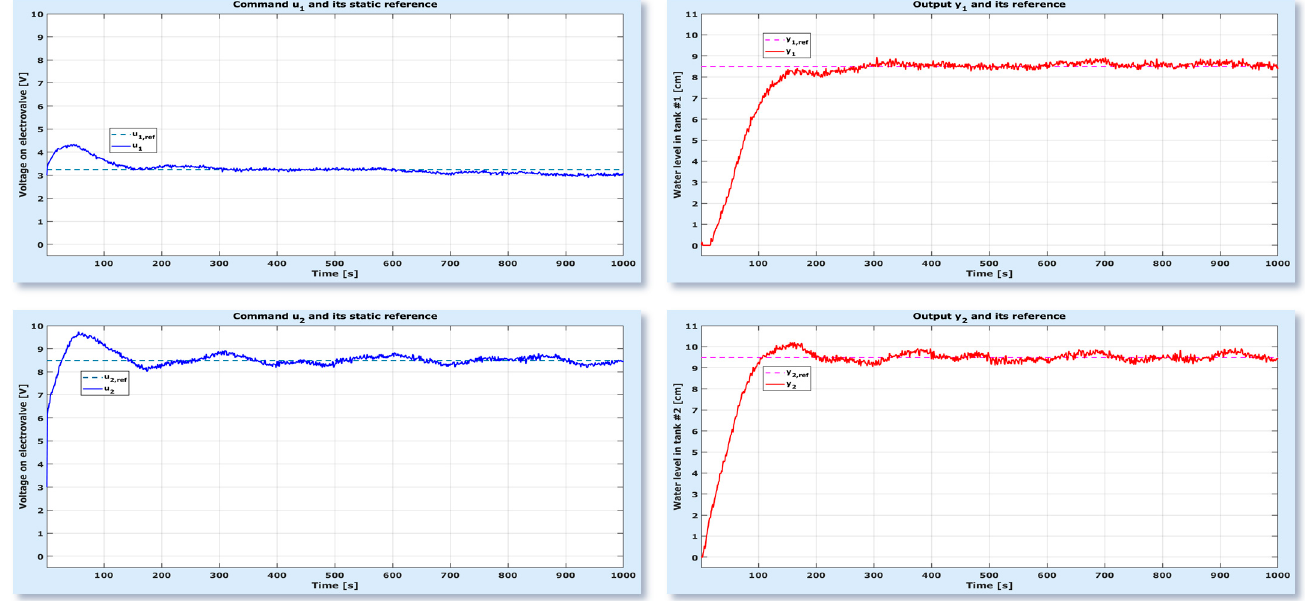
Figure 16. I/O signals for optimal PID-R controllers; in the case of <spline> idmo, Φ IFA o =